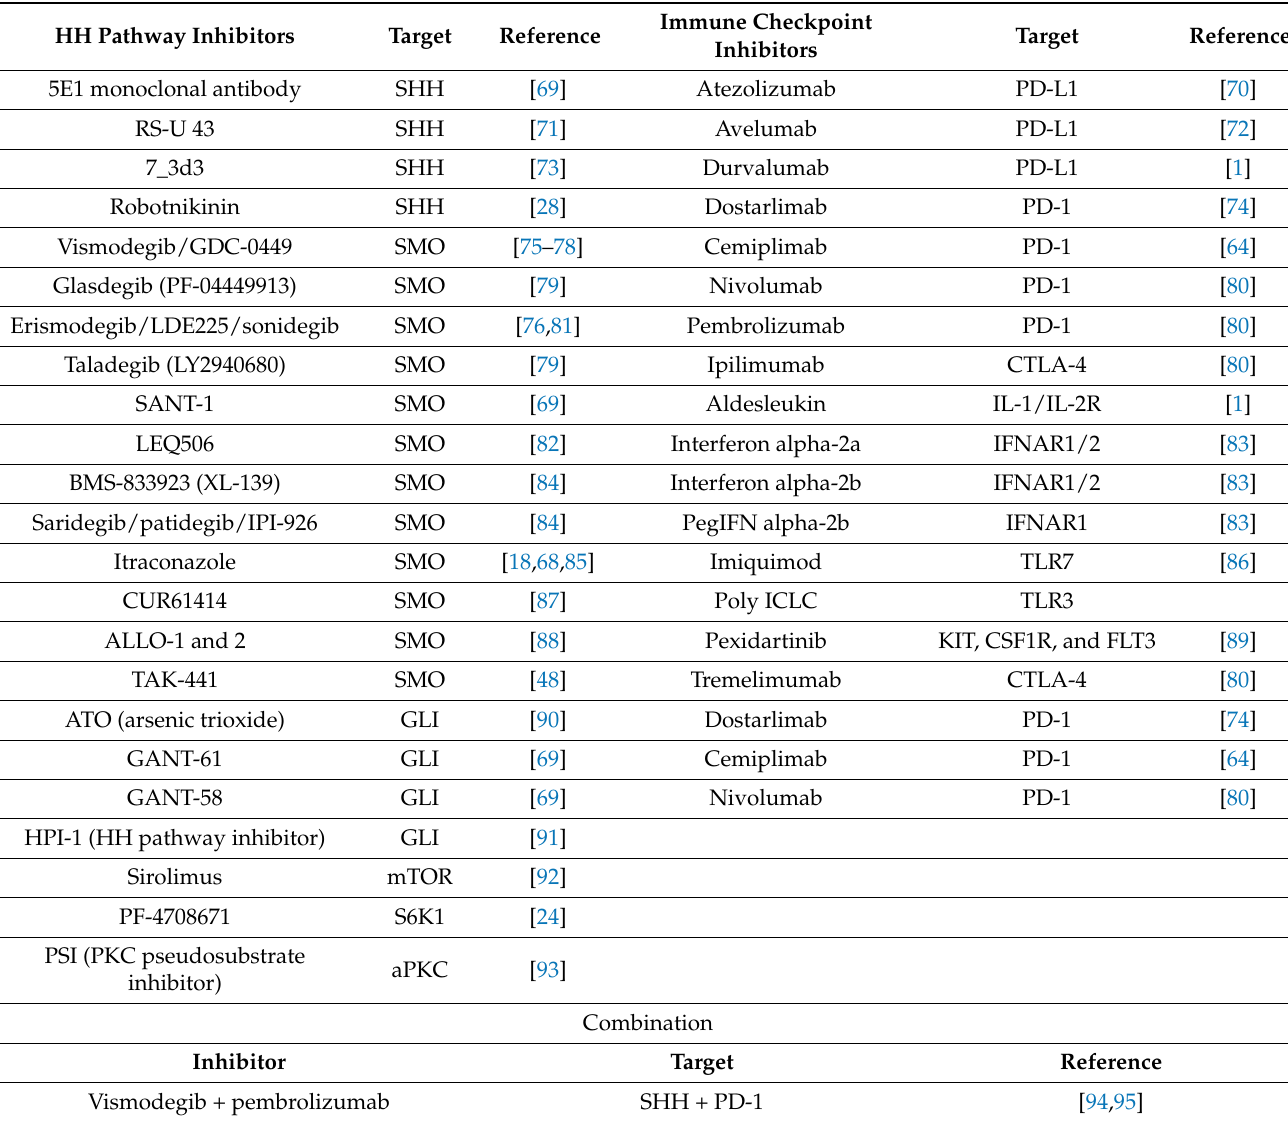
Table 1. HH pathway inhibitors in preclinical or clinical phases and the immune checkpoint inhibitors for potential combination